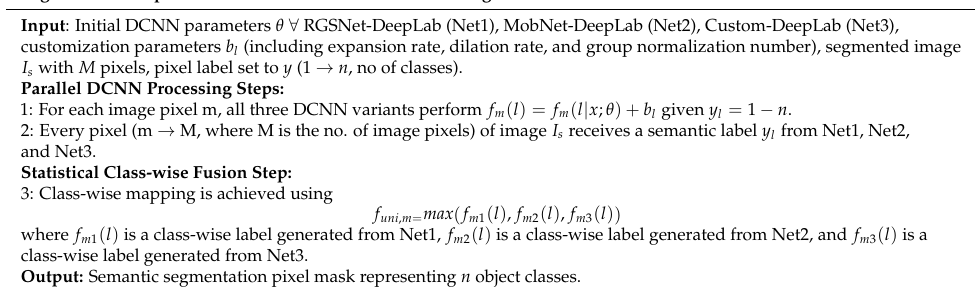
Algorithm 1: Proposed Parallel DCNN for Semi-Dark Images